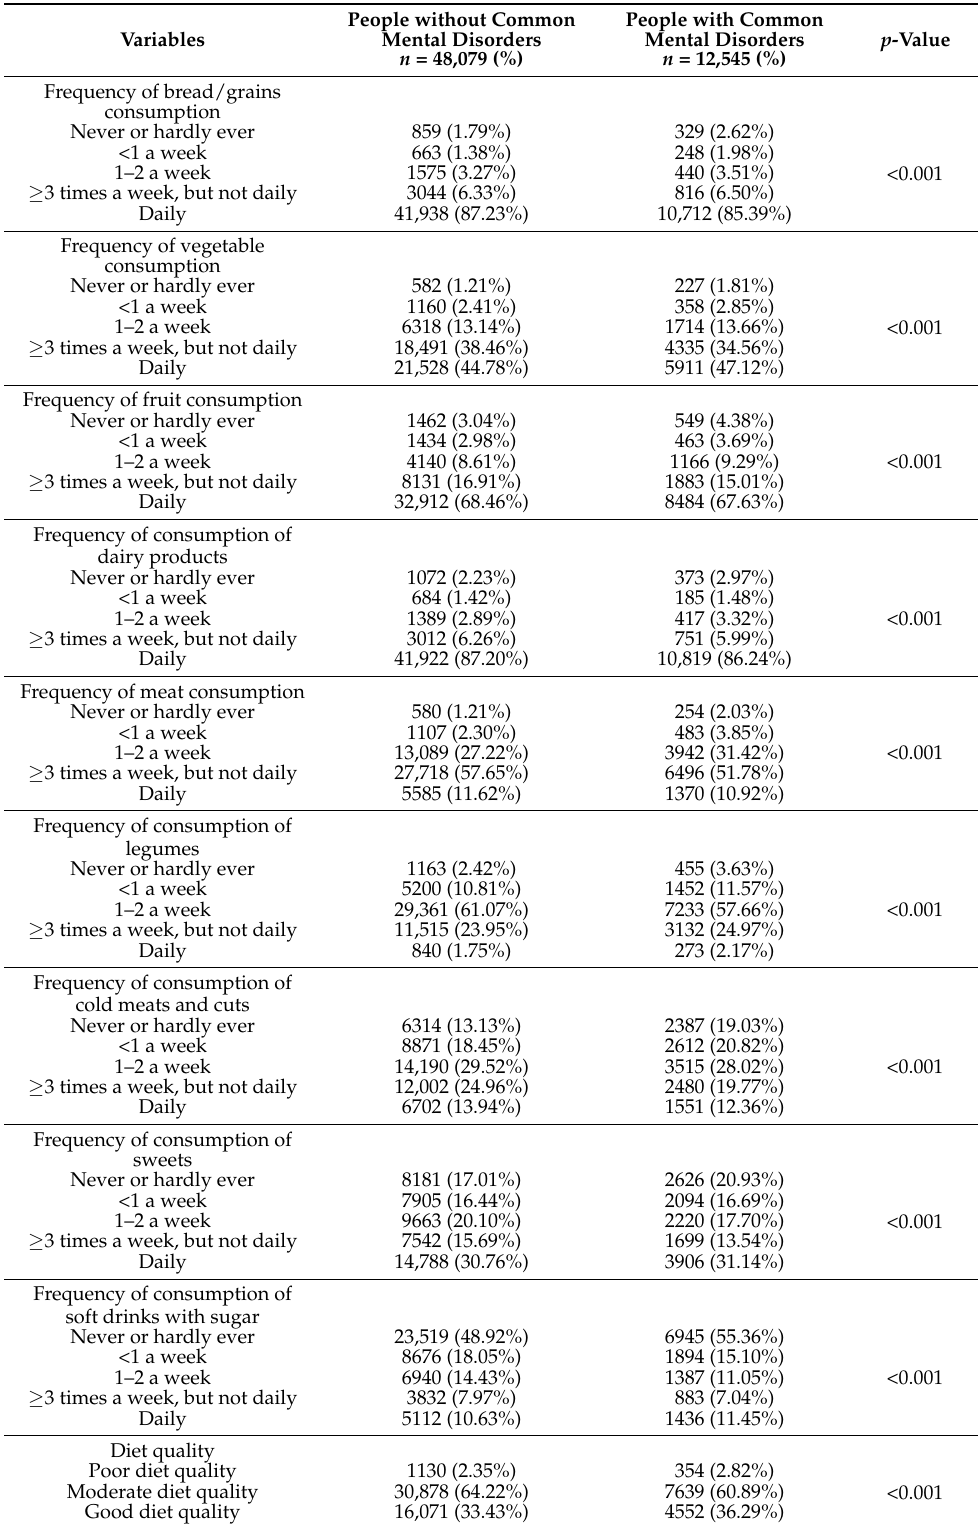
Table 2. Frequency of food consumption and diet quality according to mental status among adults from all three survey periods ( n = 60,624) (SNHS 2006, SNHS 2011/2012 and SNHS